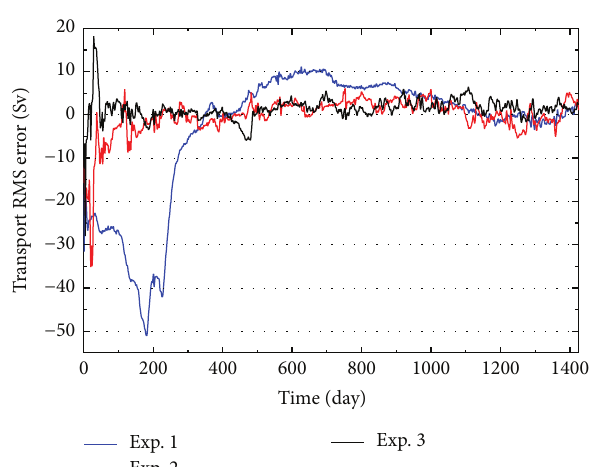
Figure 9: Time series of the differences of the Kuroshio transport at PN section of East China Sea between the three twin experiments and the truth obtained from the control run. Blue line is for Experiment 1 minus the truth, red line is for Experiment 2 minus the truth, and black line is for Experiment 3 minus the